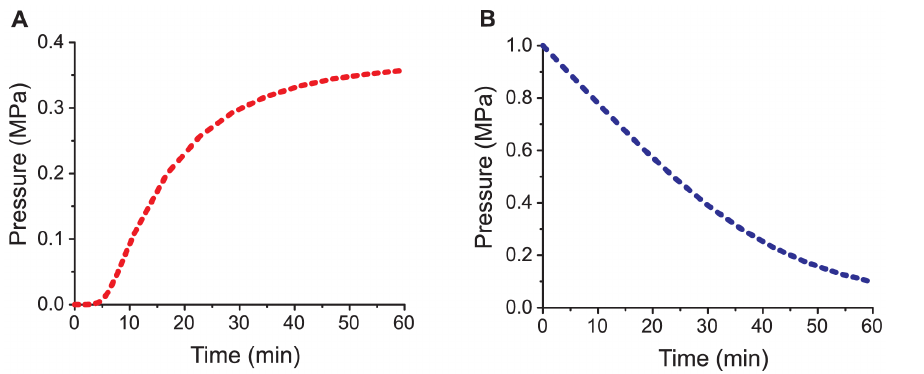
Figure 3. Dynamics of pressure buildup and release in plant extensor cells as calculated with Equation 4 and parameters based on literature values. The L p,0 value used in the calculations was 3.6 6 10 2 14 m Pa 2 1 s 2 1 [25], the cell volume was 3.23 6 10 2 13 m 3 , the surface area was 2.02 6 10 2 8 (both estimated from [24]), and V in (P in ) was V in = (3.23 6 10 2 13 )exp[1.06 6 10 2 6 P in + 0.047 ln( P in )] (developed from literature bulk elastic modulus values[24] and the definition of bulk elastic modulus[27]). In these calculations DP followed the van’t Hoff relation and f was assumed to be zero. A. Pressure buildup upon sudden introduction of an osmotic gradient with an initial DP of 1 MPa [23] B. Pressure release upon sudden disappearance of an osmotic gradient. Initial P in was 1 MPa. [23,24] The difference between the maximum pressure from the pressurization curve and the starting pressure from the depressurization curve can be accounted for by the fact that our model assumes no significant biochemical regulation of osmotic pressure during this fast pressurization. As a consequence, the influx of water leads to a decrease in DP